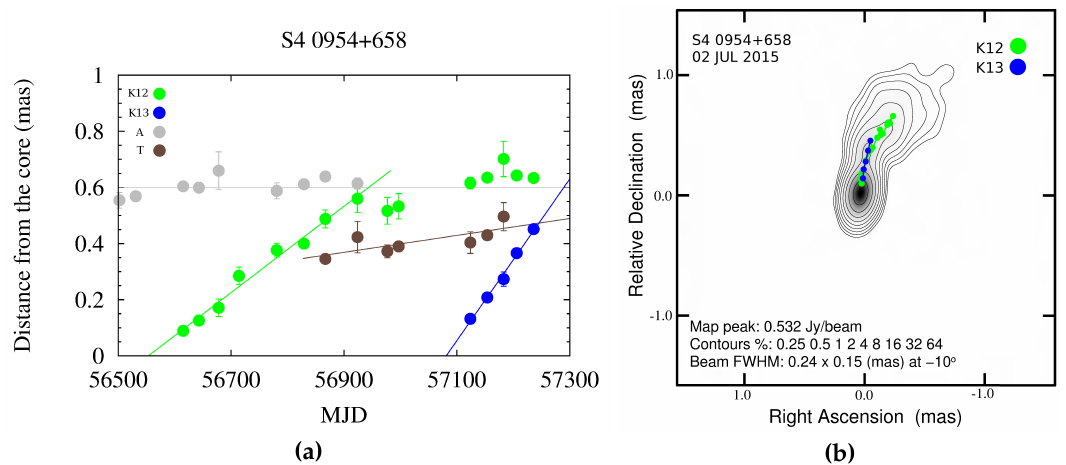
Figure 2. ( a ) Separations of knots from the VLBI-core as a function of time at 43 GHz; ( b ) 43 GHz image of S4 0954+658 with trajectories of knots